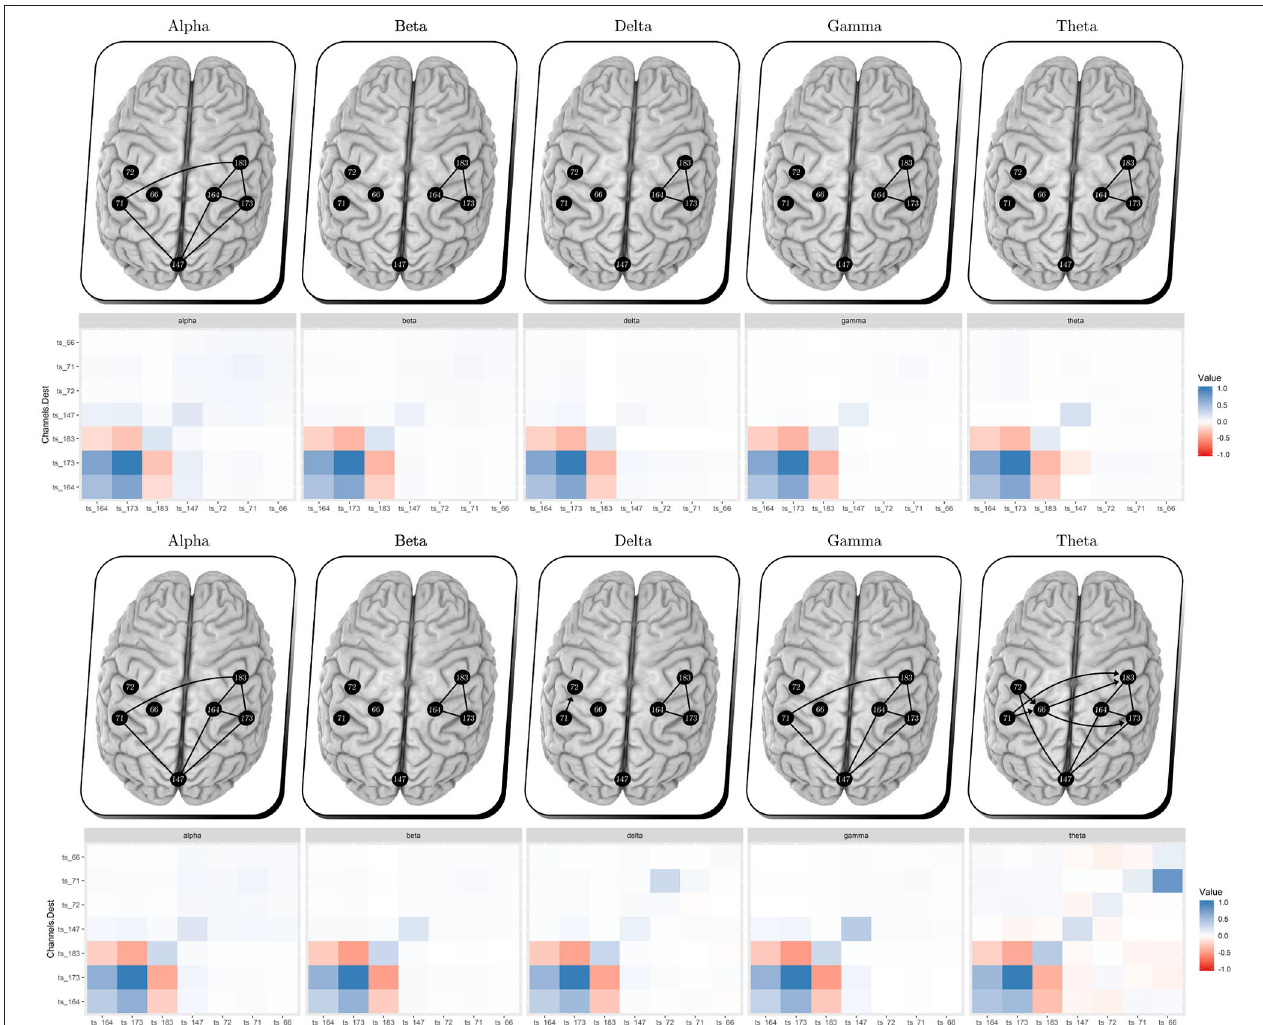
FIGURE 7 | Multiplex EEG signals, per bandpower, (top panels) resting state and (bottom panels) after unilateral HD-tDCS–Anodal Center 2 mA–stimulation. Comparing the resting state vs. post-stimulation, we obtained additional links within the gamma and theta bands during post-stimulus, which suggests an outgrowth in the electrical brain